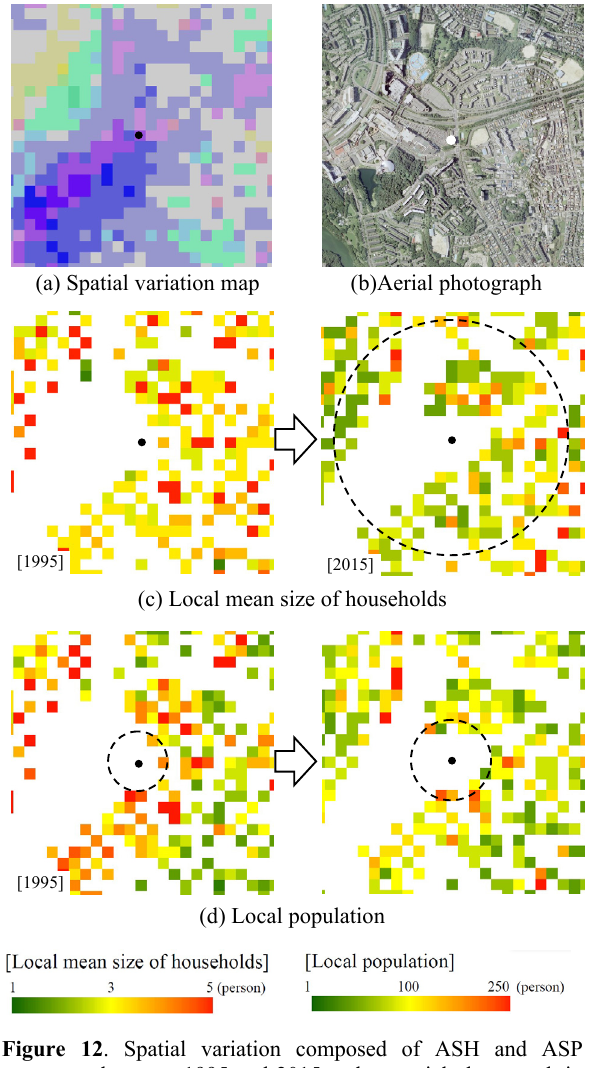
Figure 14 . Five-year trends in the representative rate of the two indices: the elderly population aged over 65 and over and the households with relatives aged 65 and over in the study area (Statistics Bureau of Japan, 2021).